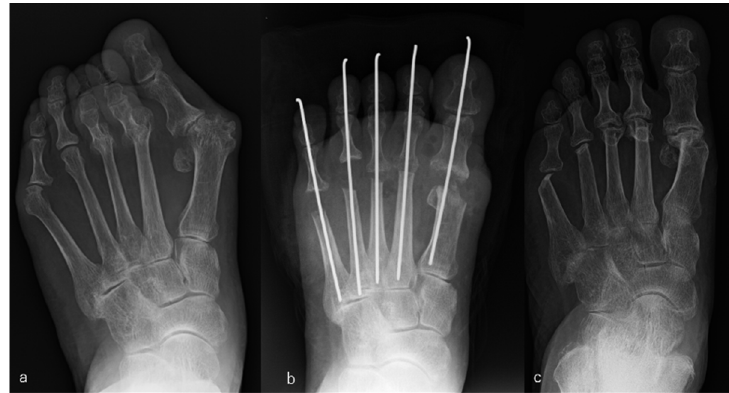
Figure 3. Rheumatoid arthritis (RA) in a 56-year-old woman. Metatarsophalangeal joint resection arthroplasty for the big and lesser toes was performed. RA had been present for 26 years. The patient received etanercept (50 mg/week), methotrexate (8 mg/week), and prednisolone (3 mg/day). Radiographic views of her left foot before surgery ( a ), immediately after surgery ( b ), and 9 years after surgery, which was the latest follow-up ( c ). Scores on the Japanese Society for Surgery of the Foot RA foot and ankle scale improved from 38 points before surgery to 79 points at the 9-year follow-up. The mean hallux valgus angle improved from 48° before surgery to 4° immediately after surgery and was 23° at the 9-year follow-up. The patient was satisfied with the clinical results at the 9-year follow-up, although the correction of the hallux valgus angle had decreased slightly and the metatarsal bone had shortened compared with the values immediately after surgery.